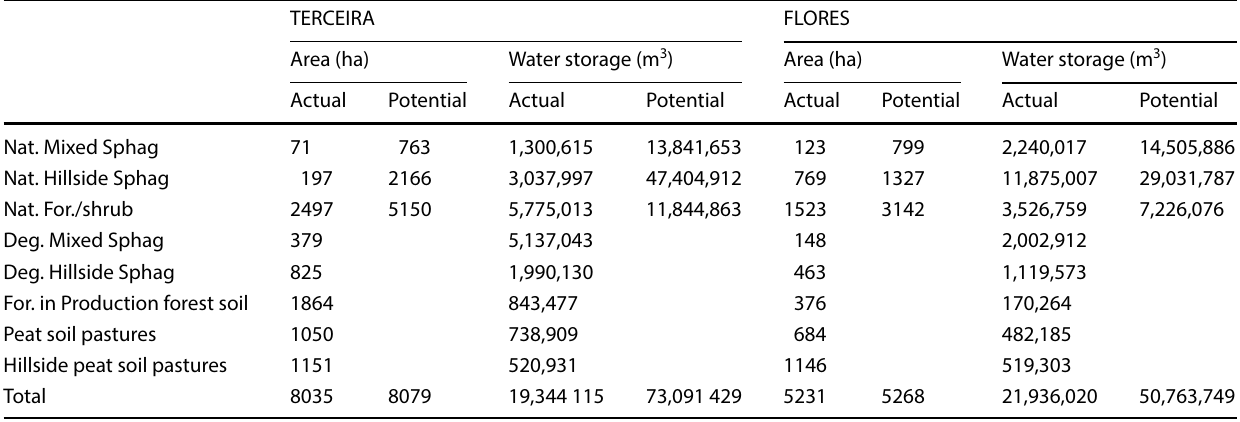
Table 2 Values of actual and potential areas of peatland distribution and associated values of water retention capacity obtained for Terceira and Flores’ types of peatlands TERCEIRA FLORES Area (ha) Water storage (m 3 ) Area (ha) Water storage (m 3 ) Actual Potential Actual Potential Actual Potential Actual